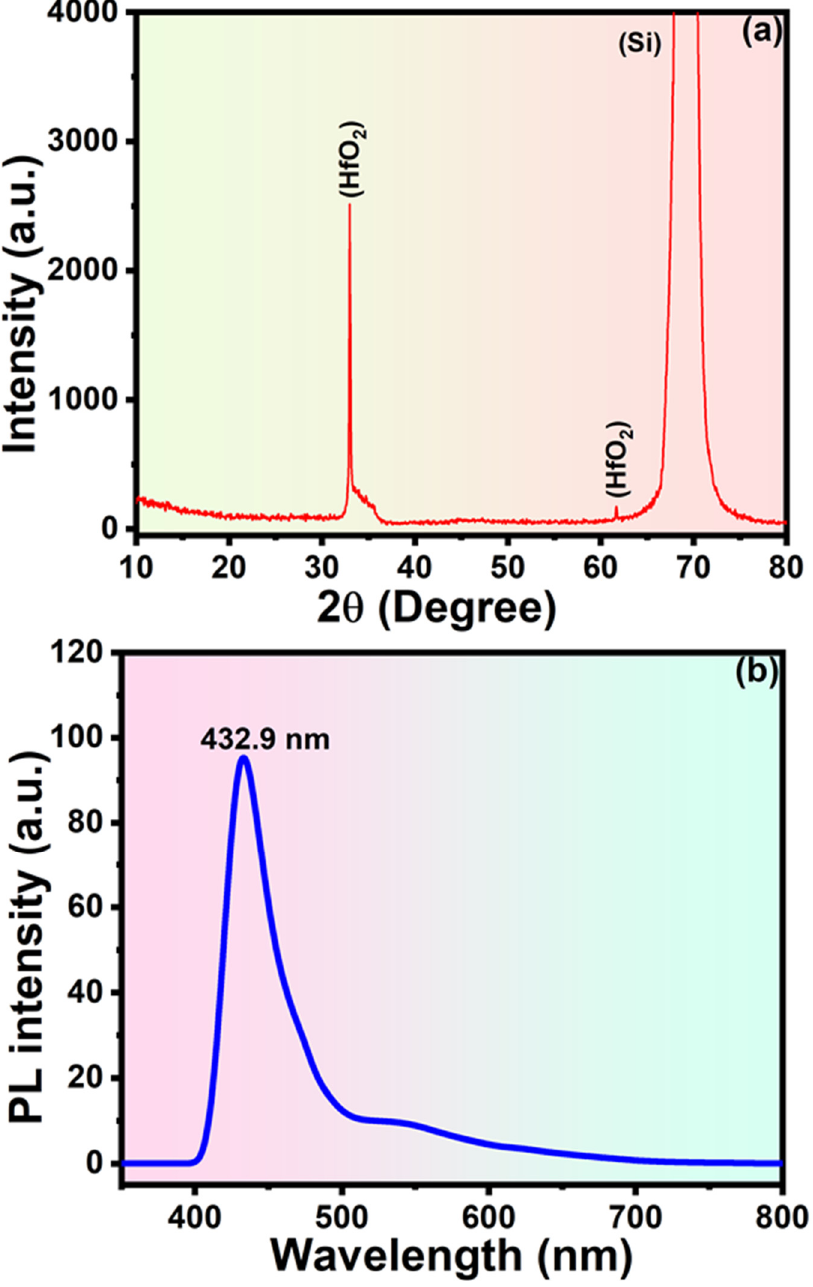
Figure 2. ( a ) XRD patterns and ( b ) Photoluminescence spectrum of HfO 2 ARC layer-based c-Si solar cell.